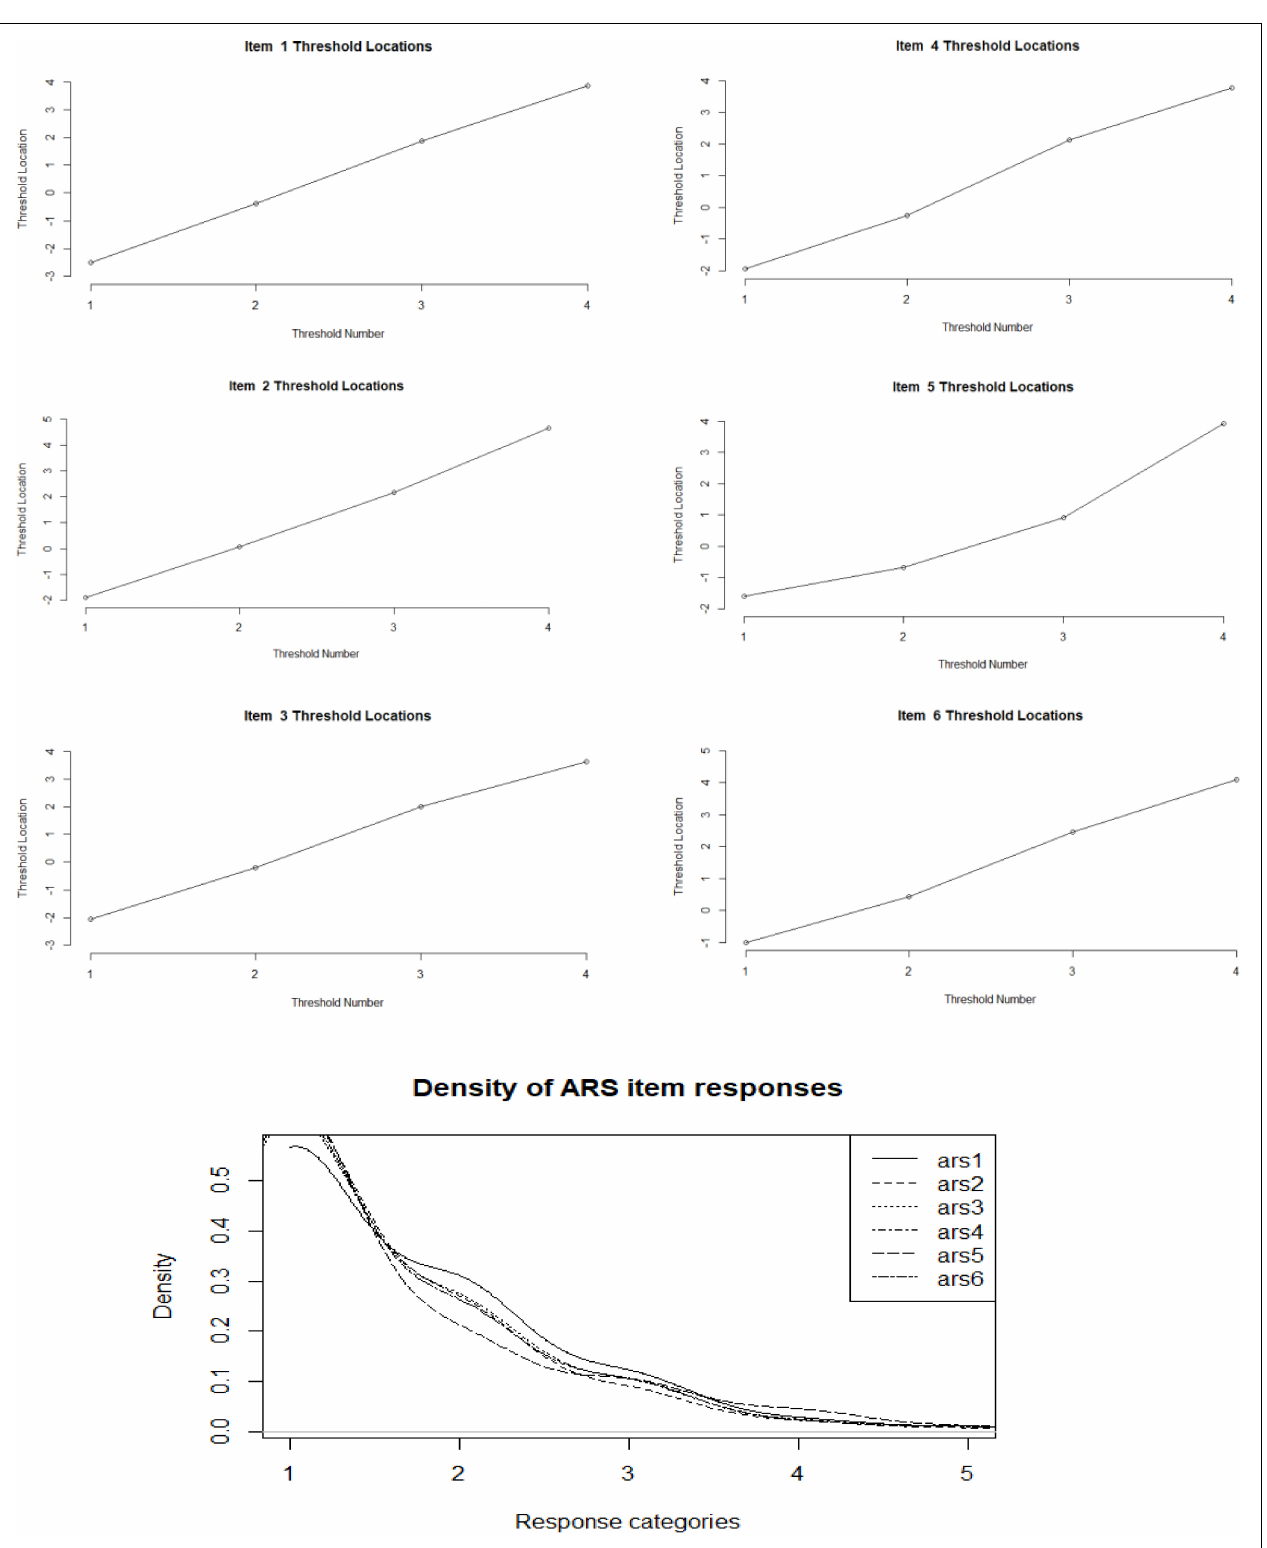
FIGURE 1 | Evaluation of threshold monotonicity and distributional regularity (SNA-6 scale).